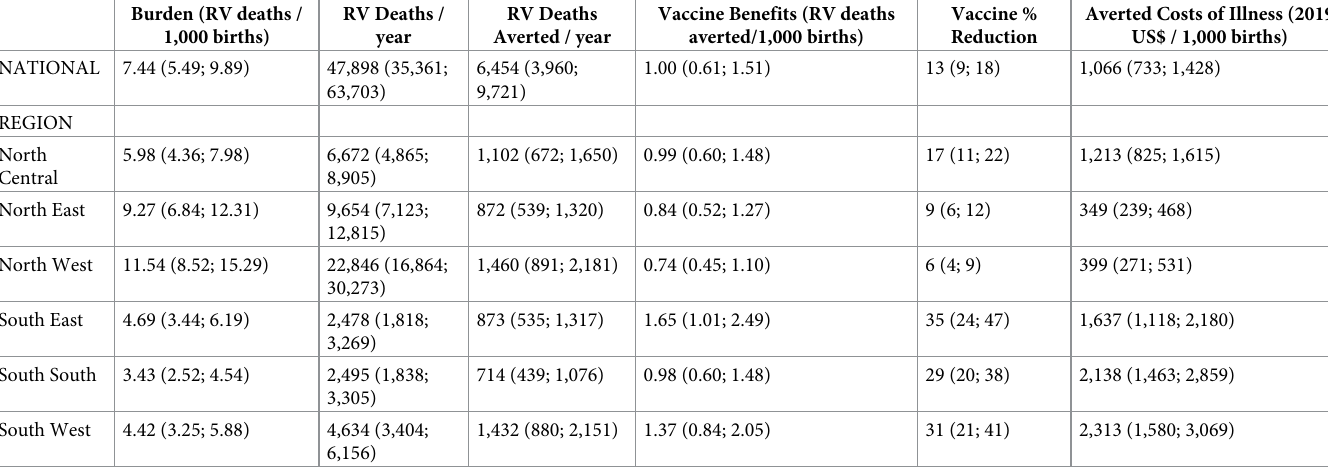
To convert rotavirus mortality into disability-adjusted life-years (DALYs), we used stan- dard DALY-estimation methods using age weighting and discounting [37]. We did not include DALYs associated with morbidity from acute cases in our estimates, because previous studies Table 2. National and regional estimates of rotavirus burden, rotavirus vaccine effectiveness and economic impact for a cohort of children in Nigeria over the first five years of